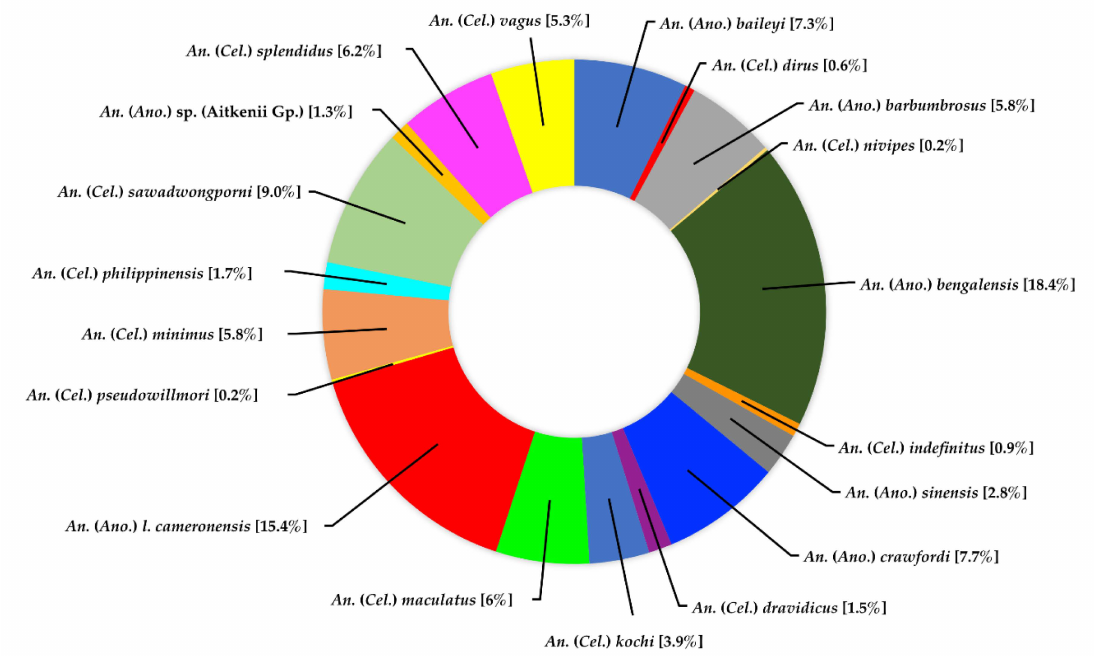
Figure 5. Species composition and abundance of mosquitoes of the genus Anopheles collected in Doi Inthanon National